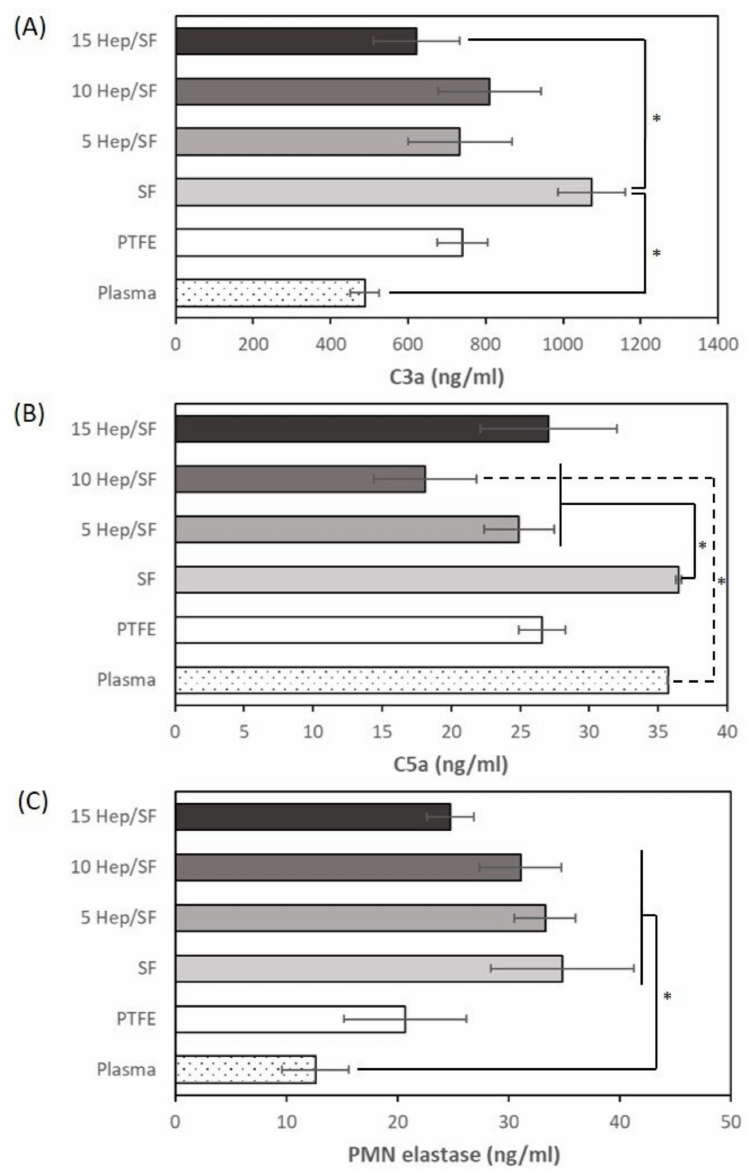
Figure 6. Complement and leukocyte activation of the samples including ( A ) C3a, ( B ) C5a, and ( C ) PMN elastase, respectively, after incubation of the samples under blood for 1h. * p < 0.05 between the